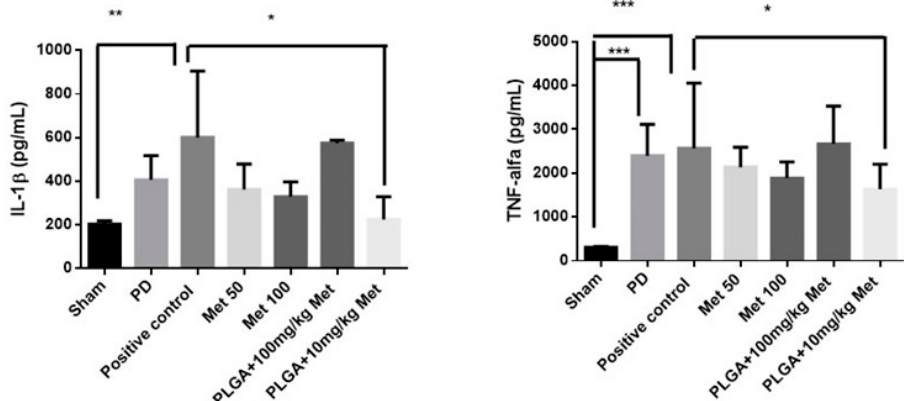
Figure 4. IL-1 β and TNF- α levels in Sham, PD; positive control; Met 50; Met 100; PLGA + 10 mg/kg Met; PLGA + 100 mg/kg. * p < 0.05, ** p < 0.01, *** p < 0.001. Analysis of variance/ANOVA test followed by Bonferroni test.